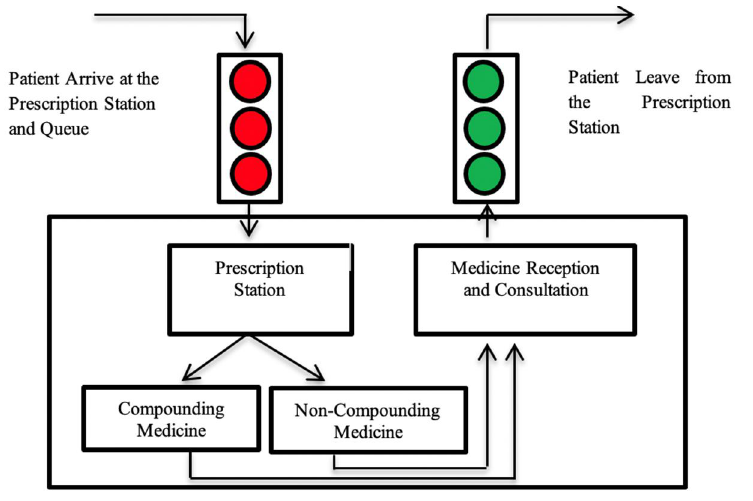
Fig. 1 Service System in Medicine